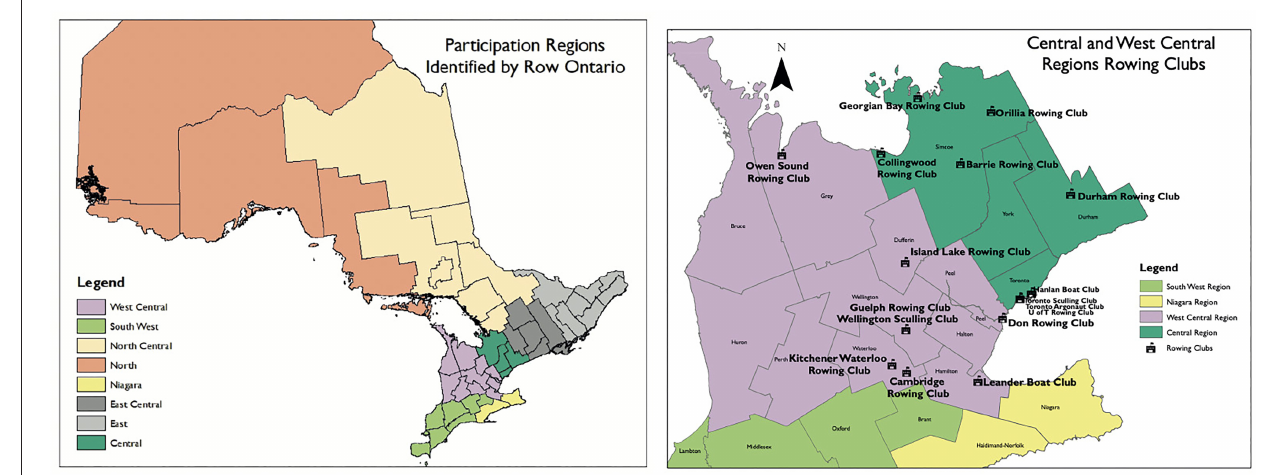
FIGURE 1 | Functional regions and example of club maps for central and west central region.